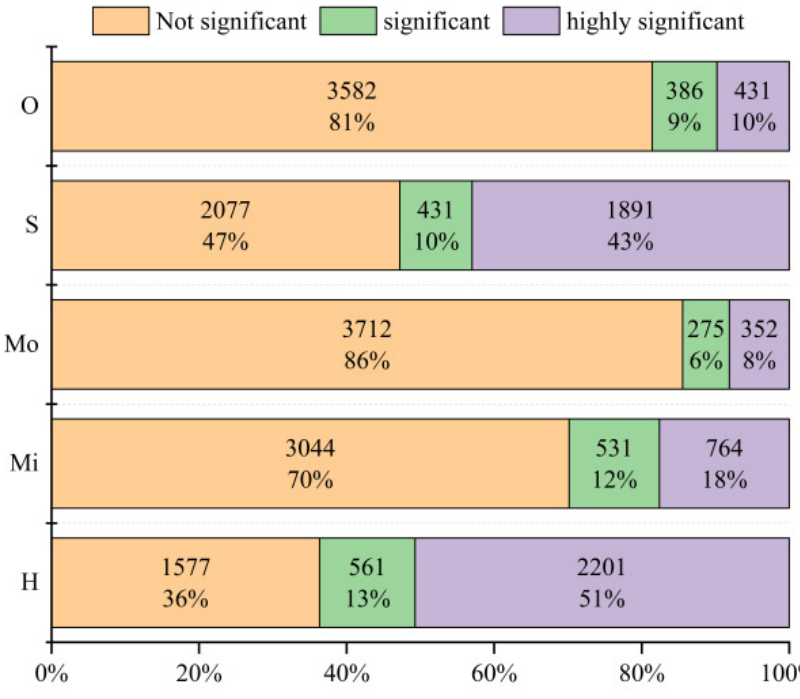
Figure 10. Significant changes in feature indices under different pest levels.